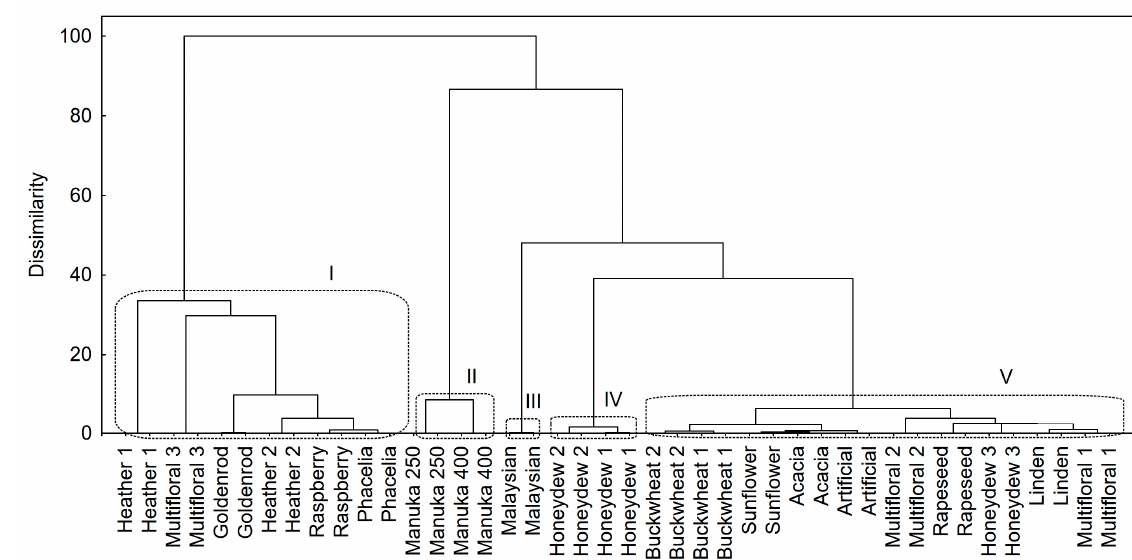
Figure 2. Cluster analysis results—the data set with 18 polyphenolic compounds was included as a bioactive fingerprint of a sample; Ward’s method was used as an amalgamation rule and squared Euclidean distances were used as a distance measure. I–V, cluster numbers.